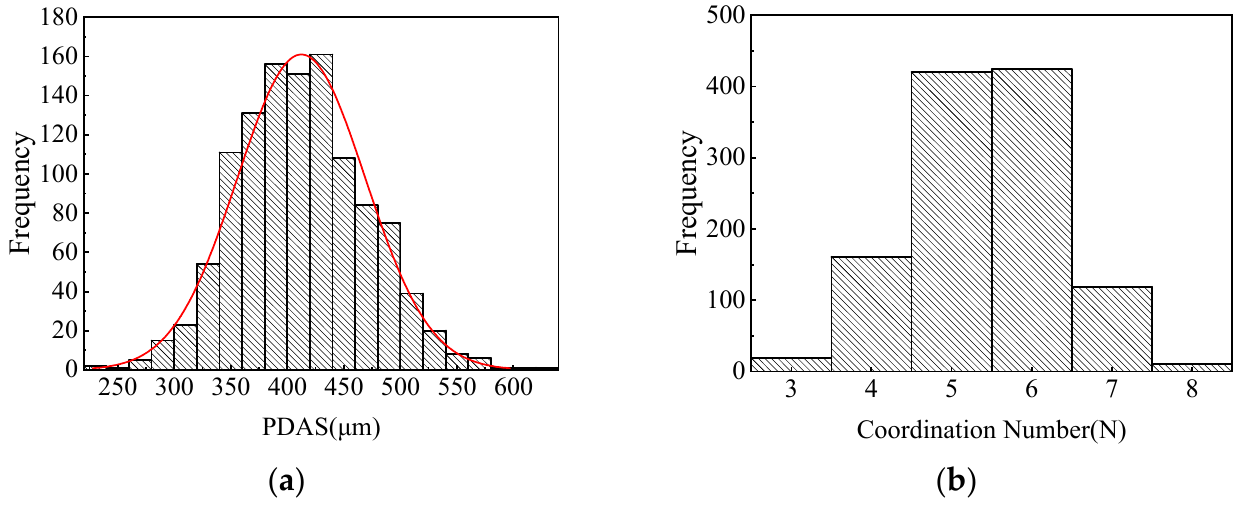
Figure 11. The Gaussian distribution of local PDAS and coordination number. ( a ) PDAS vs. frequency for HT901, λ = 415 µ m, ( b ) coordination number vs. frequency for HT901.